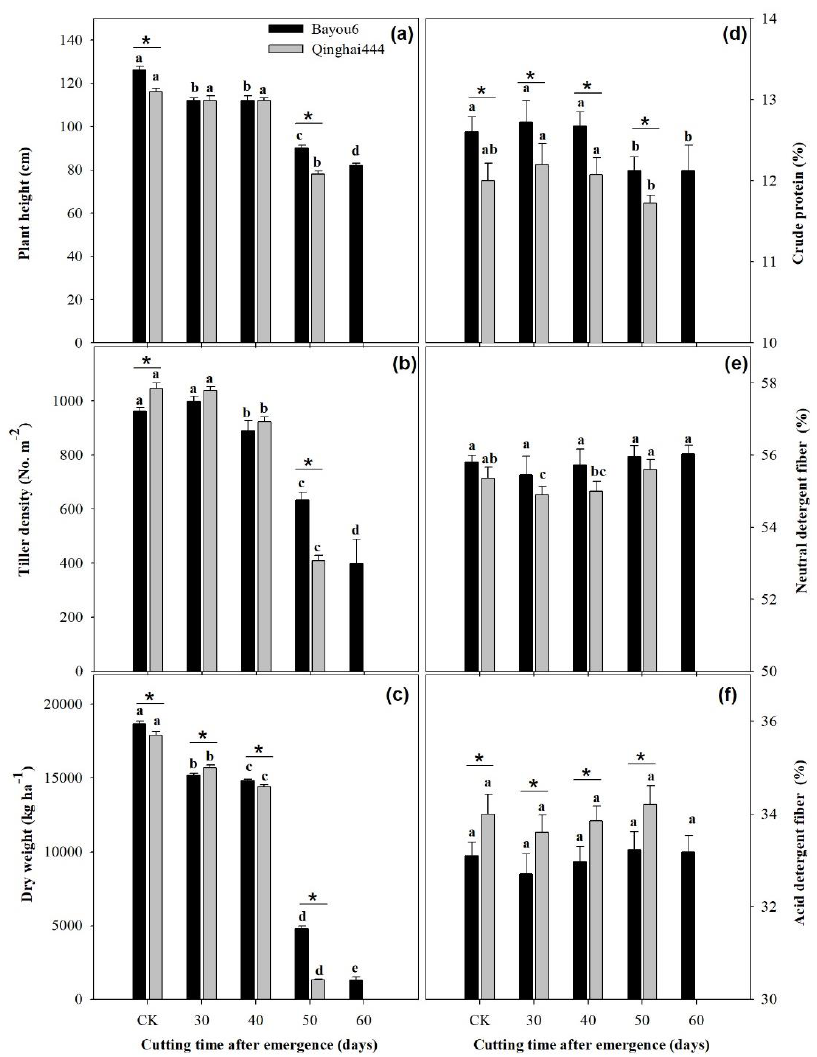
Figure 3. The agronomic characters ( a , b , c ) and forage qualities ( d , e , f ) of re-growth for the two oat species Bayou6 and Qinghai444 in the full-ripe stage. * indicates significant differences ( p < 0.05) between Bayou6 and Qinghai444 under the same treatment. The different lowercase letters indicate significant differences among treatments for each oat species. Data are means ± SE ( n = 4).